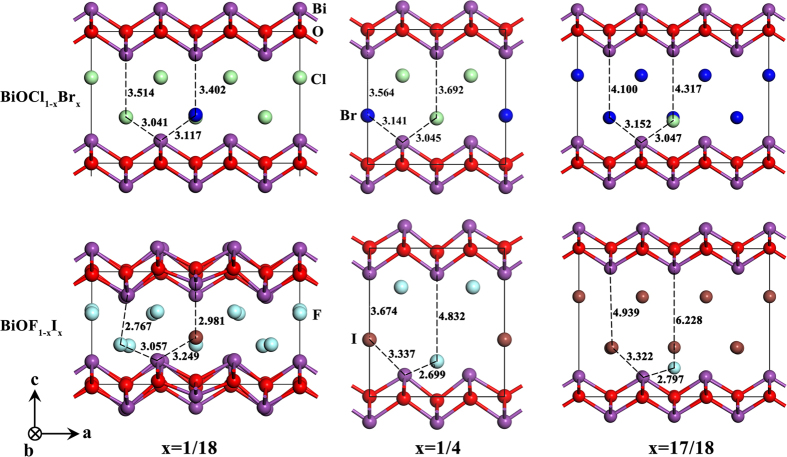
Crystal structures of BiOCl1−xBrx and BiOF1−xIx with x = 1/18, 1/4, and 17/18.